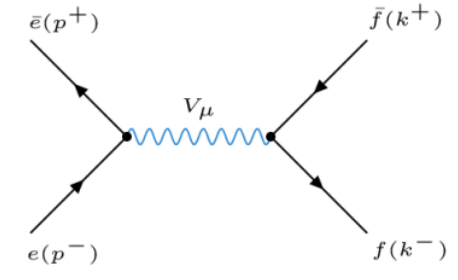
Figure 10 . Forward-backward asymmetries in e + e (cid:0) ! (cid:22) ff are important tests for axial-vector couplings. The model predict non-universality for f = (cid:22) and f = (cid:28) . Here V = (cid:13); Z; X . In our case, by assuming a Z (cid:24) g and a X (cid:24) g